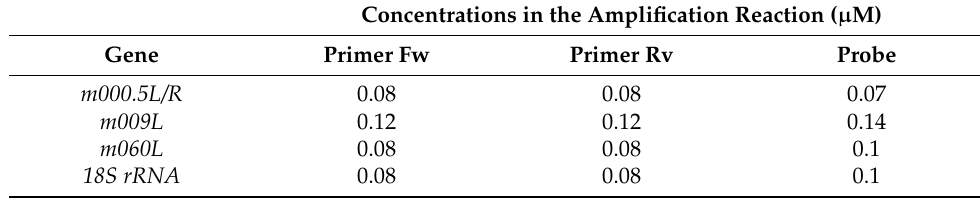
Table 3. Optimized primers and probes’ concentrations for field samples in the mPCR.